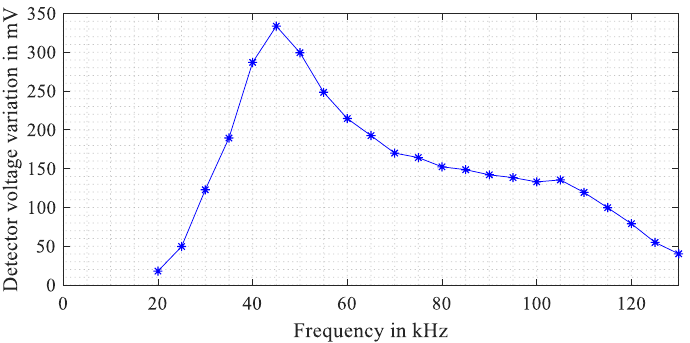
Figure 6. ∆ V detec for a frequency range between 20 kHz to 60 kHz.